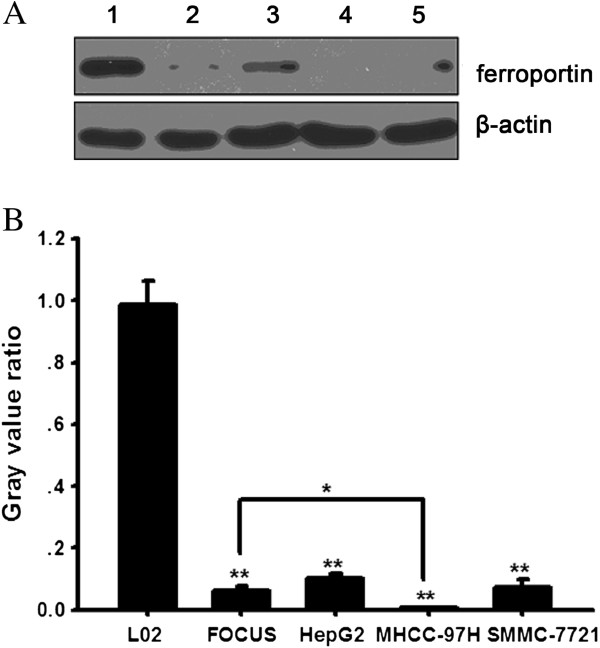
The expression level of ferroportin in different cell lines. A) Western blotting: 1, Normal human liver cell line L02; 2, FOCUS; 3, HepG2; 4, MHCC-97H; 5, SMMC-7721. βMactin was shown as the loading control. B) Statistical graph of the expression level of ferroportin in different cell lines. **The expression difference of ferroportin between normal human liver cell line and hepatocellular carcinoma (HCC) cell lines all had statistical significance, P <0.01. *The difference of ferroportin expression between MHCC-97H and other HCC cell lines had statistical significance, P <0.05 (for convenience, the single asterisk has only been shown between MHCC-97H and FOCUS; it is the same consequence for the comparison between MHCC-97H and HepG2/ SMMC-7721).